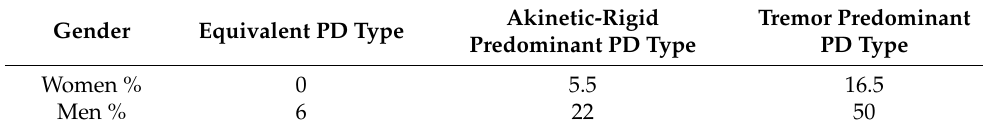
Table 1. Distribution of the PD sample according to the clinical subtypes. Gender